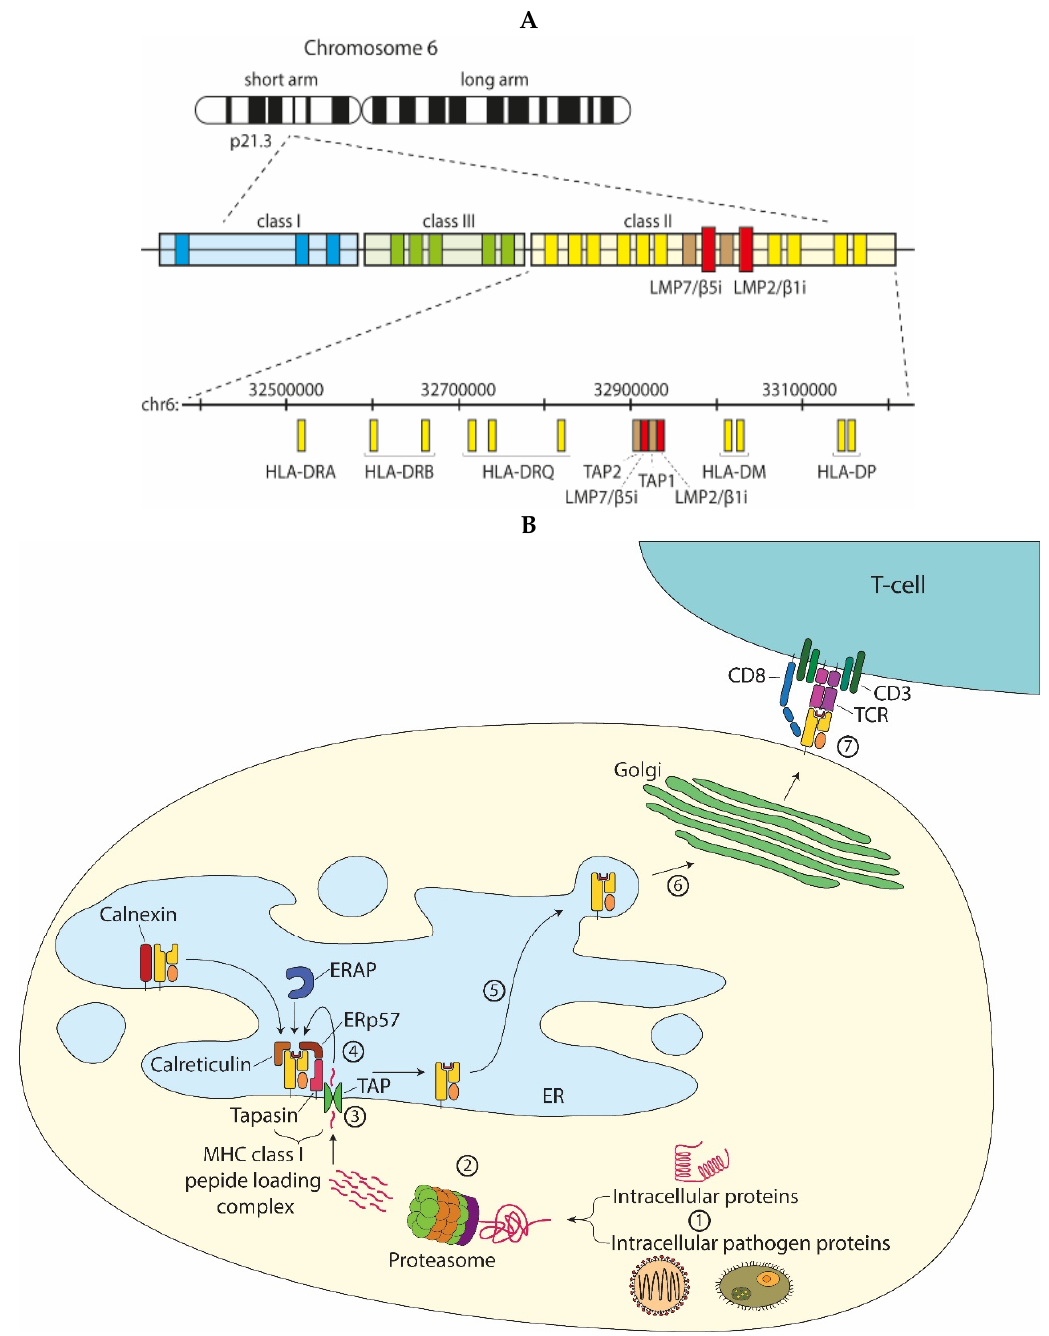
Figure 3. Proteasomes and MHC class I antigen processing. ( A ) The MHC class II region, in humans on chromosome 6p, encodes the two facultative proteasome subunits LMP7/ β 5i and LMP2/ β 1i, adjacent to the TAP heterodimer; ( B ) Intracel- lular proteins or pathogen-derived proteins (1) that are targeted for degradation are recognized by the 19S proteasome, unfolded and then degraded by the 20S proteasome (2). The proteolyzed peptides are transported from the cytosol into the ER lumen by the transporter associated with antigen processing (TAP) (3). ER-resident aminopeptidases (ERAPs) may trim the peptide N-terminus to generate peptides with an appropriate size for MHC class I binding. MHC class I chaper- ones stabilize the empty MHC class I molecules, assist in peptide loading, or perform quality control to select the best binding peptide (4). Upon peptide binding, the peptide-MHC class I complex dissociates from the peptide loading com- plex and traffics through the ER to the Golgi complex (6) and subsequently to the cell surface for presentation to cytotoxic CD8 + T-cells. The T-cell receptor (TCR) in complex with CD3 and CD8 on the T-cell surface binds to the peptide-MHC class I complex and upon recognition induces activation of the CD8 + T-cell (7).